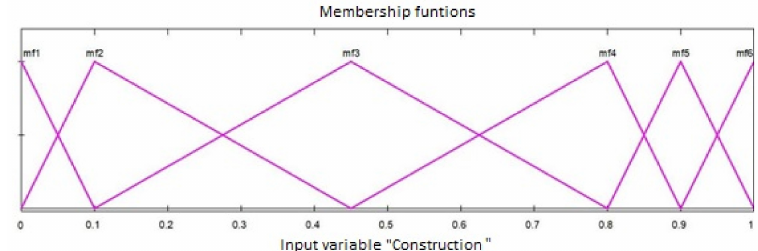
Figure 12. MFs of the input variable “Construction utility”.